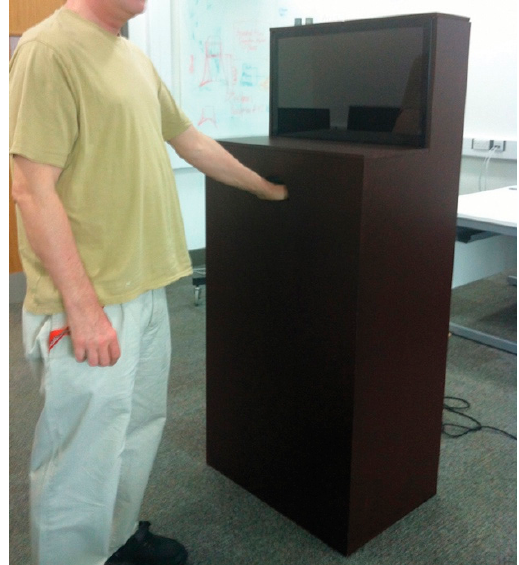
Figure 1. A person demonstrating height of the Teletalker (TT) kiosk and use of the volume mechanism. When a person placed their hand into the hole, the volume was turned on. Permission granted by Dr Marianne Markowski.